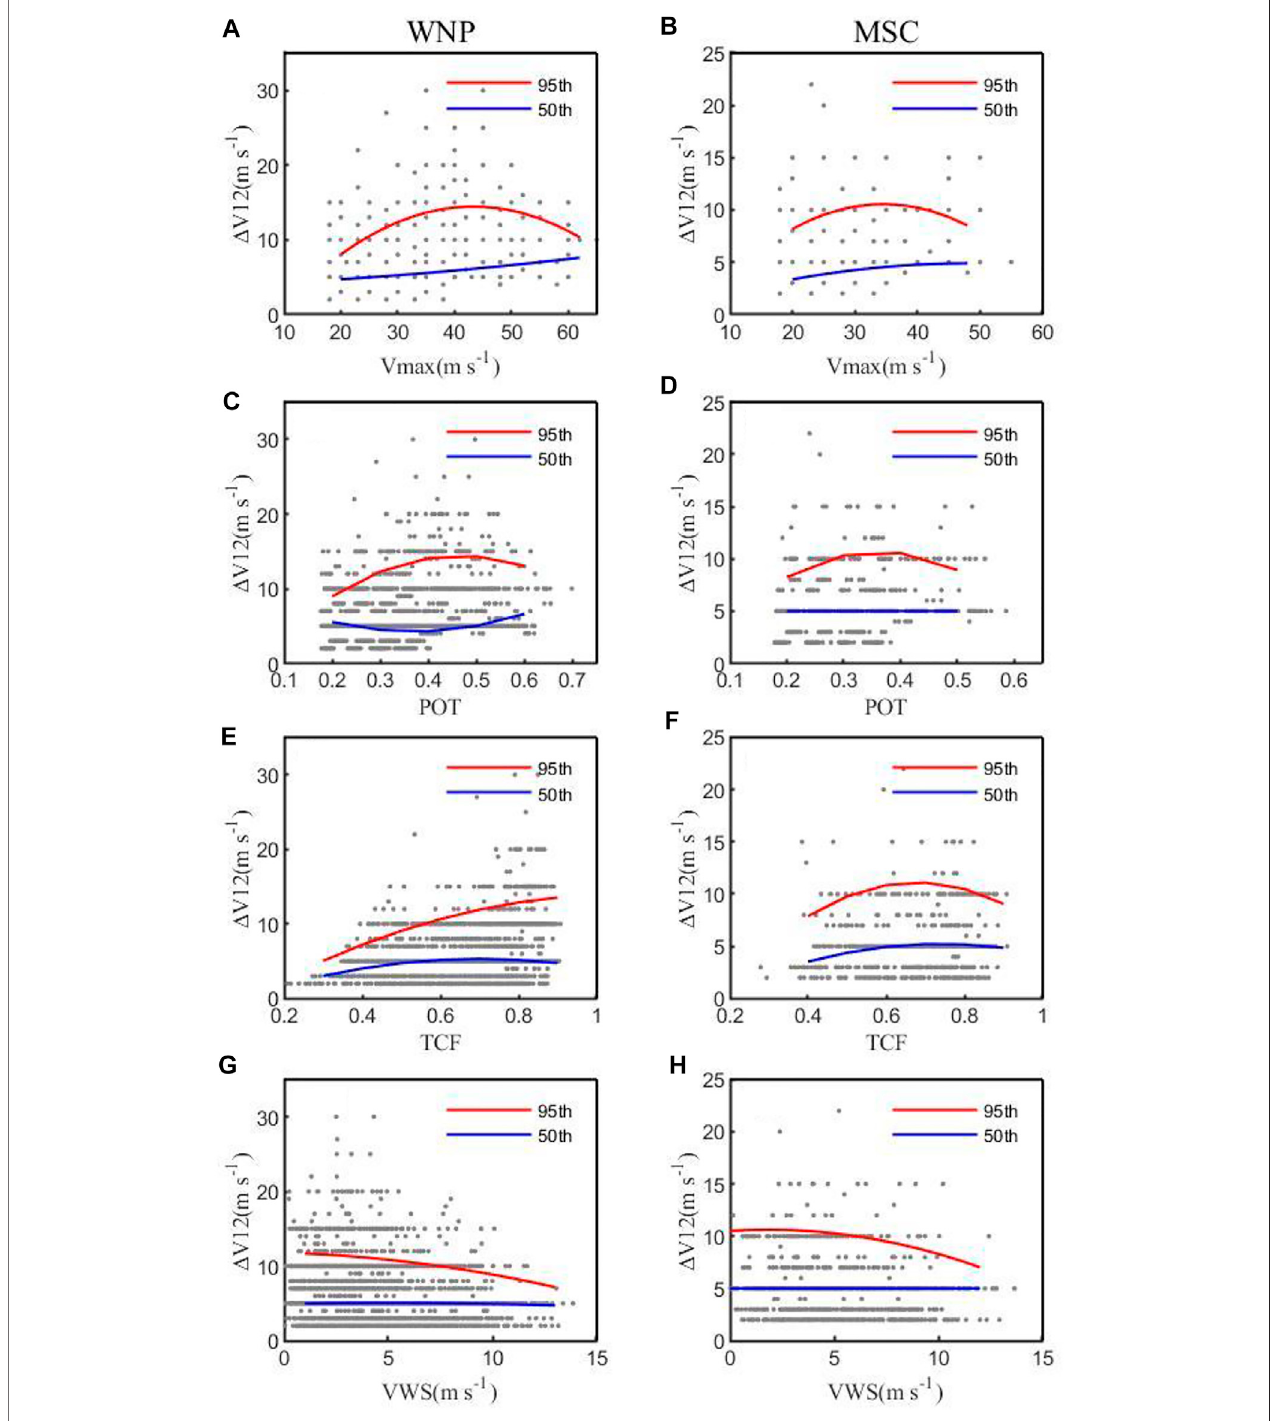
FIGURE 5 | Scatter diagrams of TC intensi fi cation rate (IR) against (A,B) Vmax (m s − 1 ), (C,D) POT, (E,F) TCF, and (G,H) VWS between 300 and 850 hPa (m s − 1 ) over (A,C,E,G) the WNP and (B,D,F,H) the MSC. The red and blue curves are the 95th and 50th percentiles of IR for the given storm intensity, respectively, for the corresponding sample sizes. POT, the ratio of Vmax to its theoretical MPI; TCF, TC fullness; VWS, vertical wind shear.